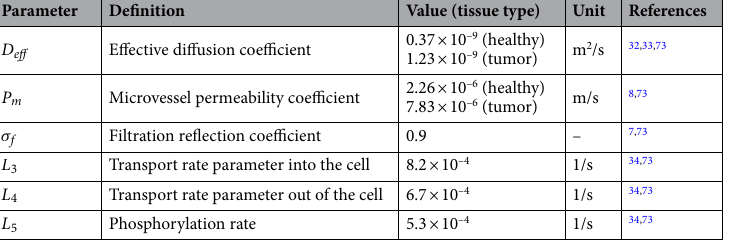
Table 2. Parameters for spatiotemporal distribution modeling of radiopharmaceutical